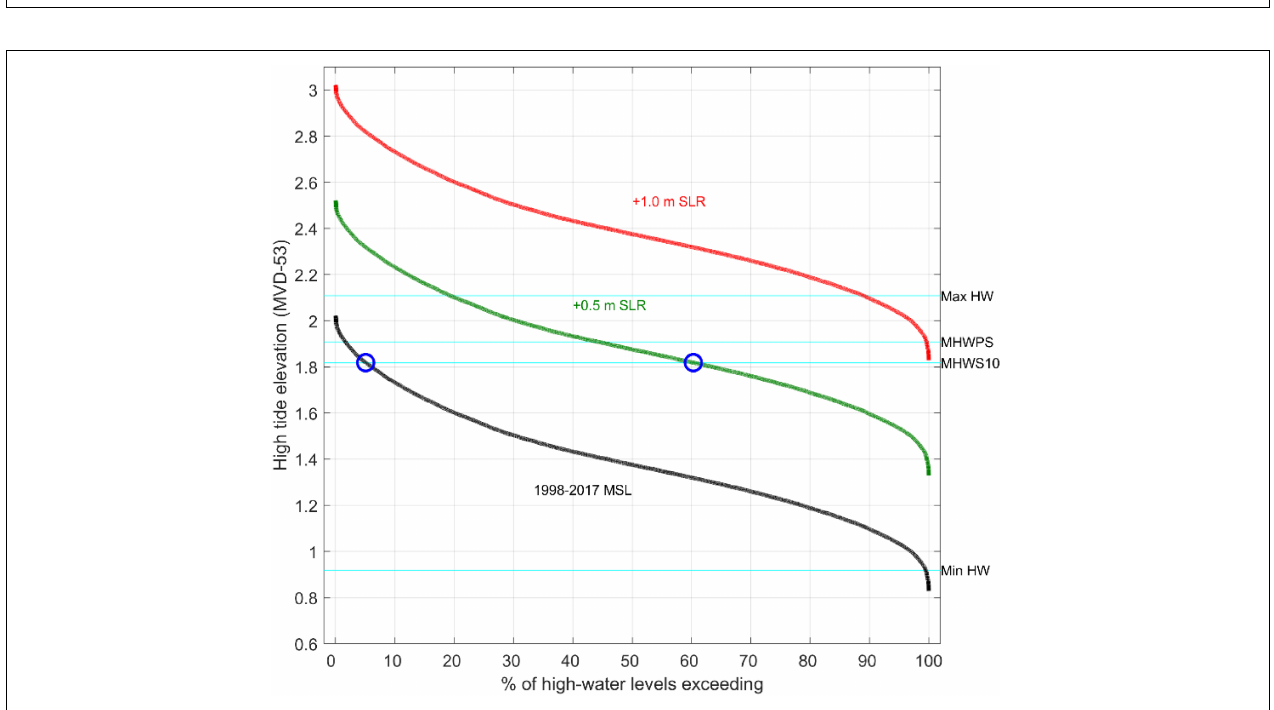
FIGURE 2 | Tidal high-water exceedance nomographs for Tararu (Thames, Coromandel, New Zealand), at present-day mean sea level (MSL) and also offset by + 0.5 and + 1.0 m sea-level rise. Max HW, maximum predicted astronomical tide, MHWPS, mean high-water perigean springs, MHWS10, high-tide height exceeded by the highest 10% of all predicted high tides, Min HW, minimum predicted astronomical tide. (MVD-53 is the regional vertical datum).